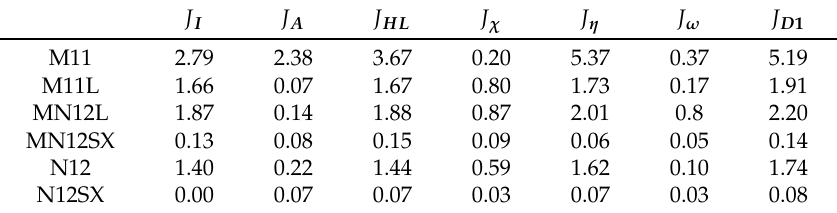
Table 1. Average descriptors J I , J A , J HL , J χ , J η , J ω , J D 1 for the KK, KAK, KA2K, KA3K, KA4K and